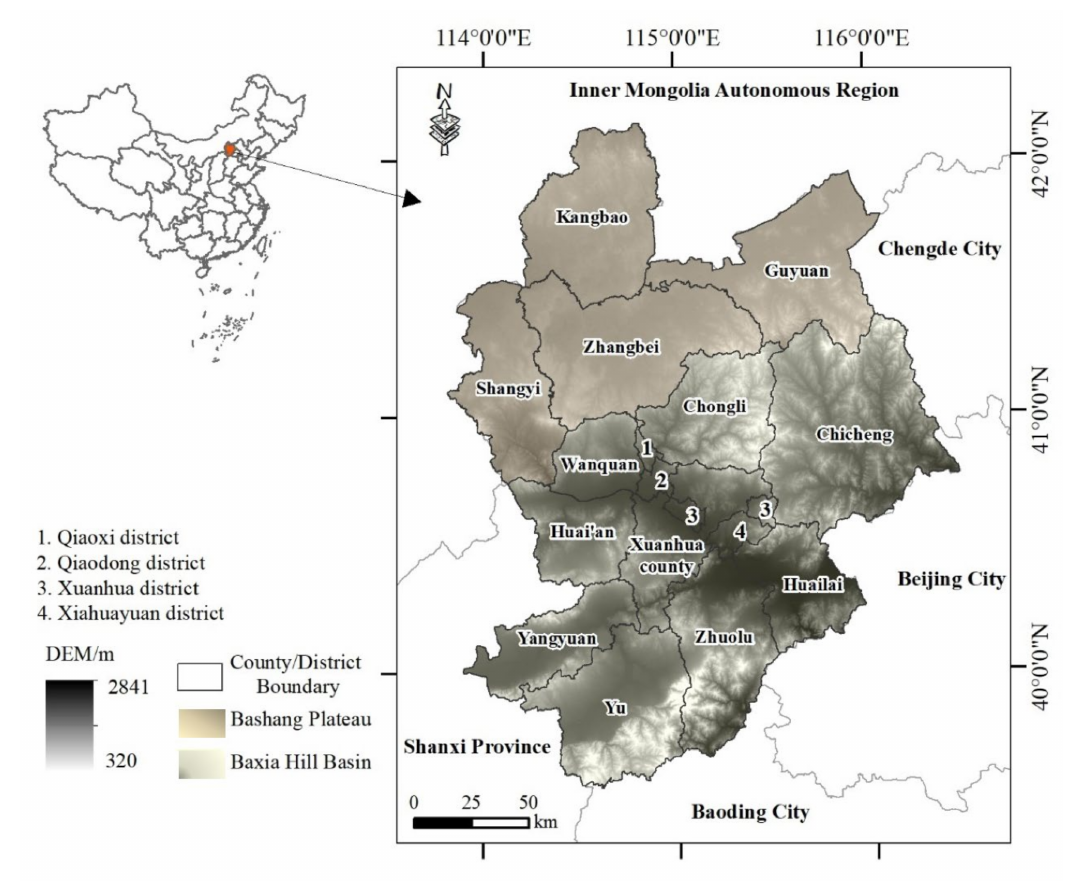
Figure 2. Geographical location of Zhangjiakou